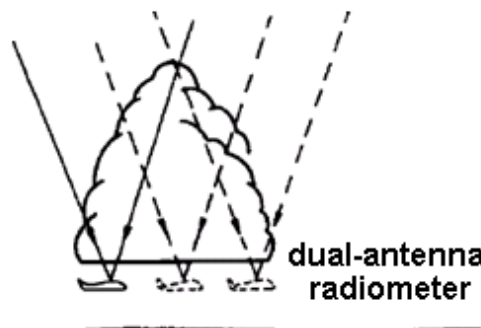
Fig. 1. An airborne cloud tomography configuration proposed by Warner et al. (1985). The aircraft carries a single upward-looking radiometer, which switches automatically between two fixed-direction antennas, and flies along a horizontal line just under a cloud.